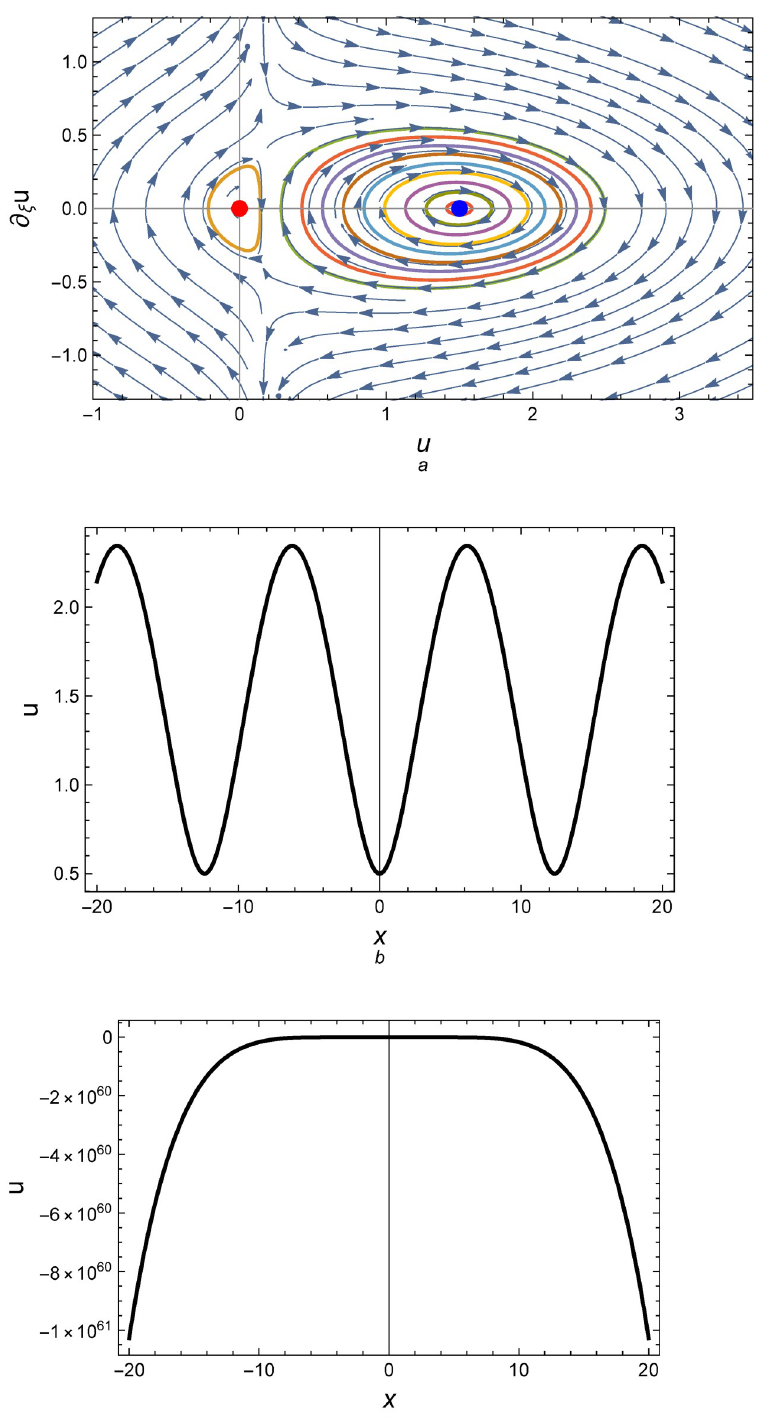
Fig 1. (a) Phase portrait for system (5) for the values c 0 = 1.2, c 1 = − 1, c 2 = 1, c 3 = 4.44541, D = 0, k = 1, α = 1, γ = 1, λ = 0.3, � = 1, A = 0, and B = − 1, (b) Profile of the solution according to the central point (Right-Blue point), and (c) Profile of the solution according to the central point (Origin-Red